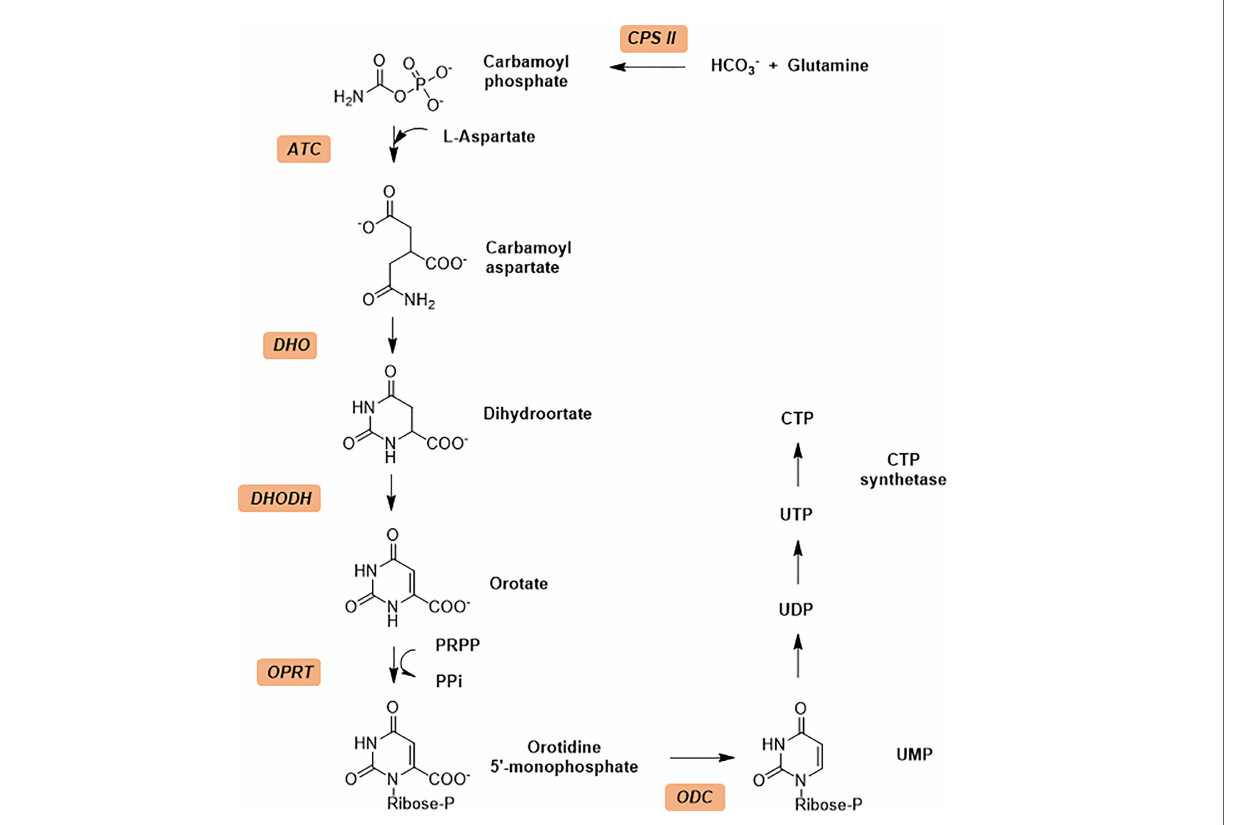
FIGURE 1 | The de novo pyrimidine biosynthesis pathway. Enzymes in de no pathway are italicized and colored with light orange. Enzymes: CPS II, carbamoyl phosphate synthetase II; ATCase, aspartate transcarbamoylase; DHO, dihydroorotase; DHODH, dihydroorotate dehydrogenase; OPRT, orotate phosphoribosyl transferase; ODC, orotidine 5 ’ -monophosphate